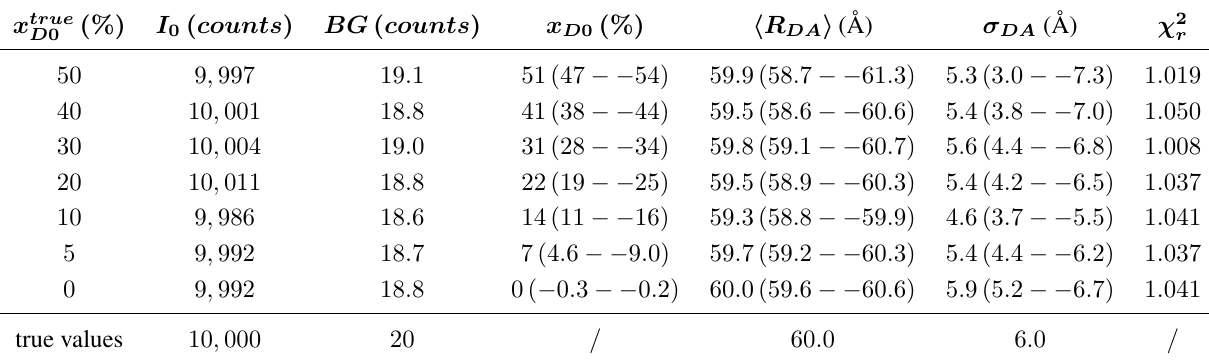
Table A2. Same fitting parameters as described in Table A1. The true value of the mean (cid:105) = 60 Å which corresponds to a low FRET inter-dye distance is (cid:104) R DA